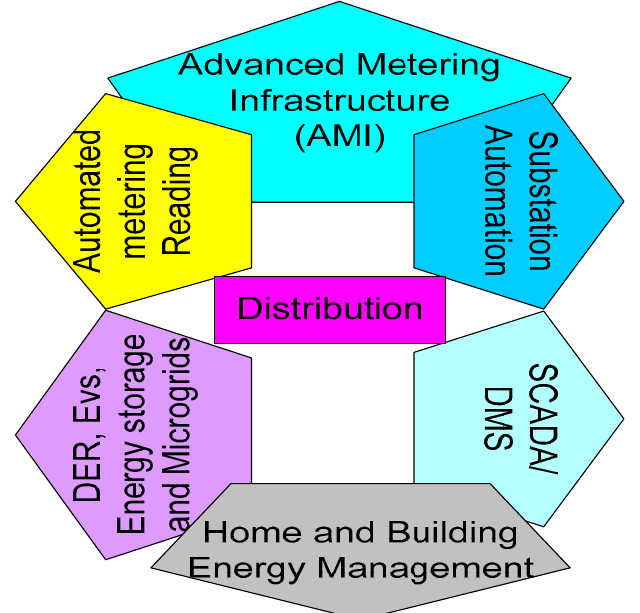
Figure 6. Application of IoT for electricity distribution.